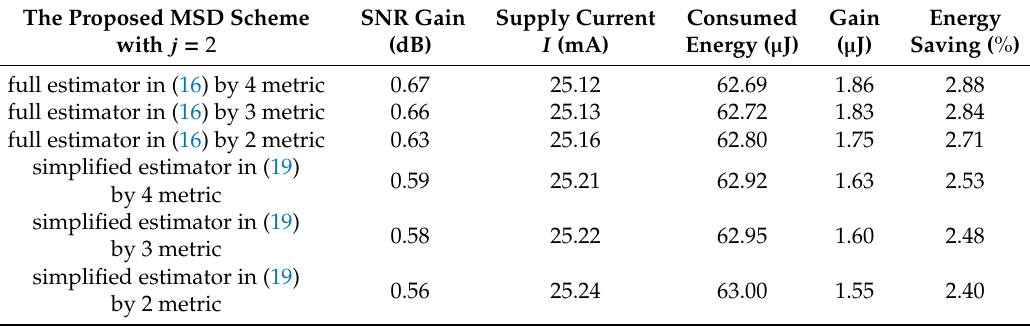
Table 2. At PER = 1 × 10 − 2 , supply current for transmission and transmission energy gain achieved by the proposed MSD scheme in the sink node over the pure AWGN